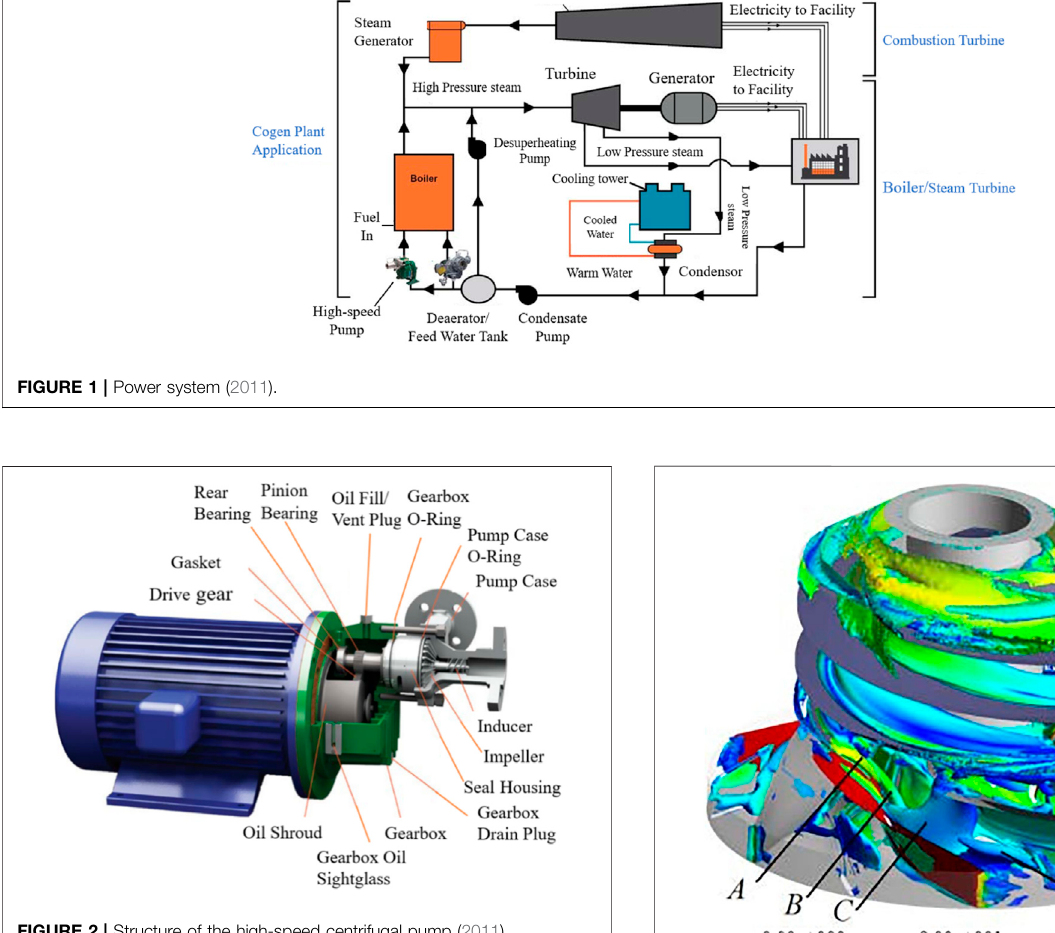
FIGURE 2 | Structure of the high-speed centrifugal pump (2011).